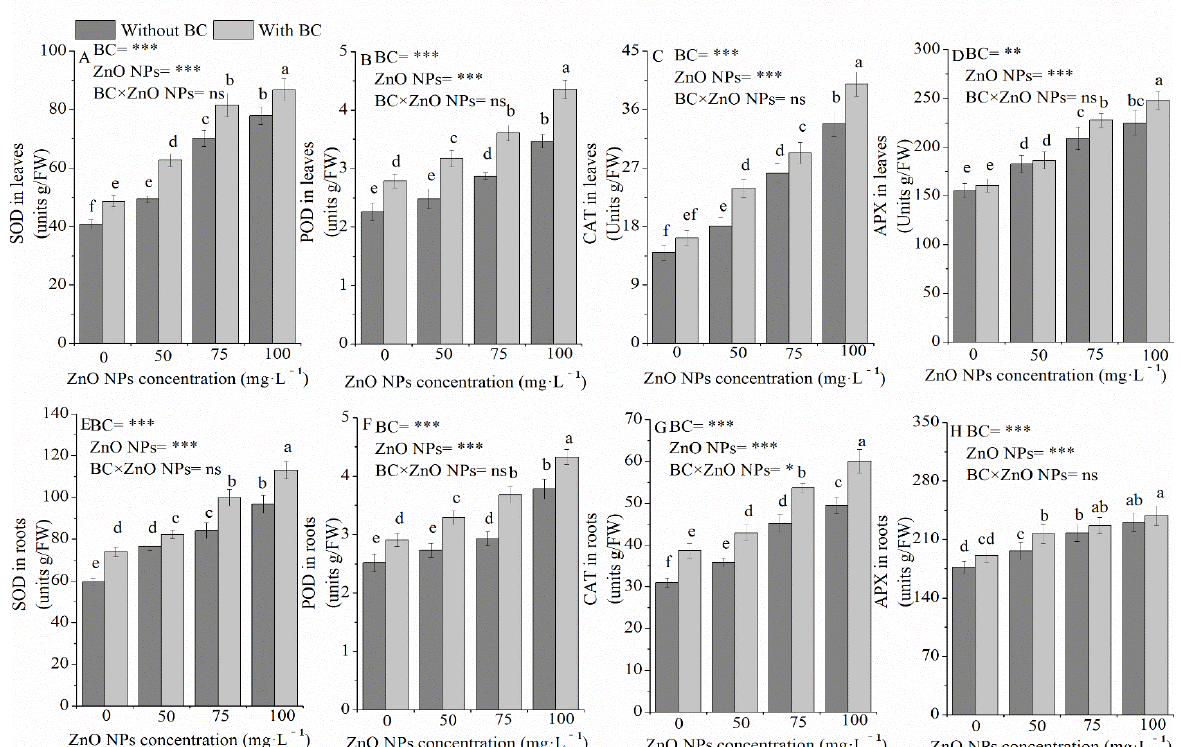
Figure 3. Effects of foliar-applied ZnO NPs alone and combined with bamboo biochar on ( A ) SOD in leaf, ( B ) POD in leaf, ( C ) CAT in leaf, ( D ) APX in leaf, ( E ) SOD in root, ( F ) POD in root, ( G ) CAT in root, and ( H ) APX in root in maize plants under Cd stress. Different letters on the bars demonstrate the significant differences between treatments at p ≤ 0.05. In the figures: ns: non-significant; * significant at 0.05, ** significant at 0.01, and *** significant at 0.001